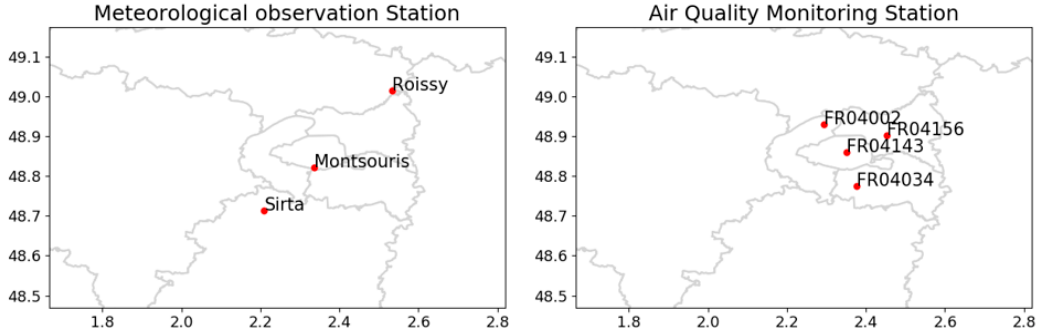
Figure 2. Maps of the meteorological and air quality monitoring stations.